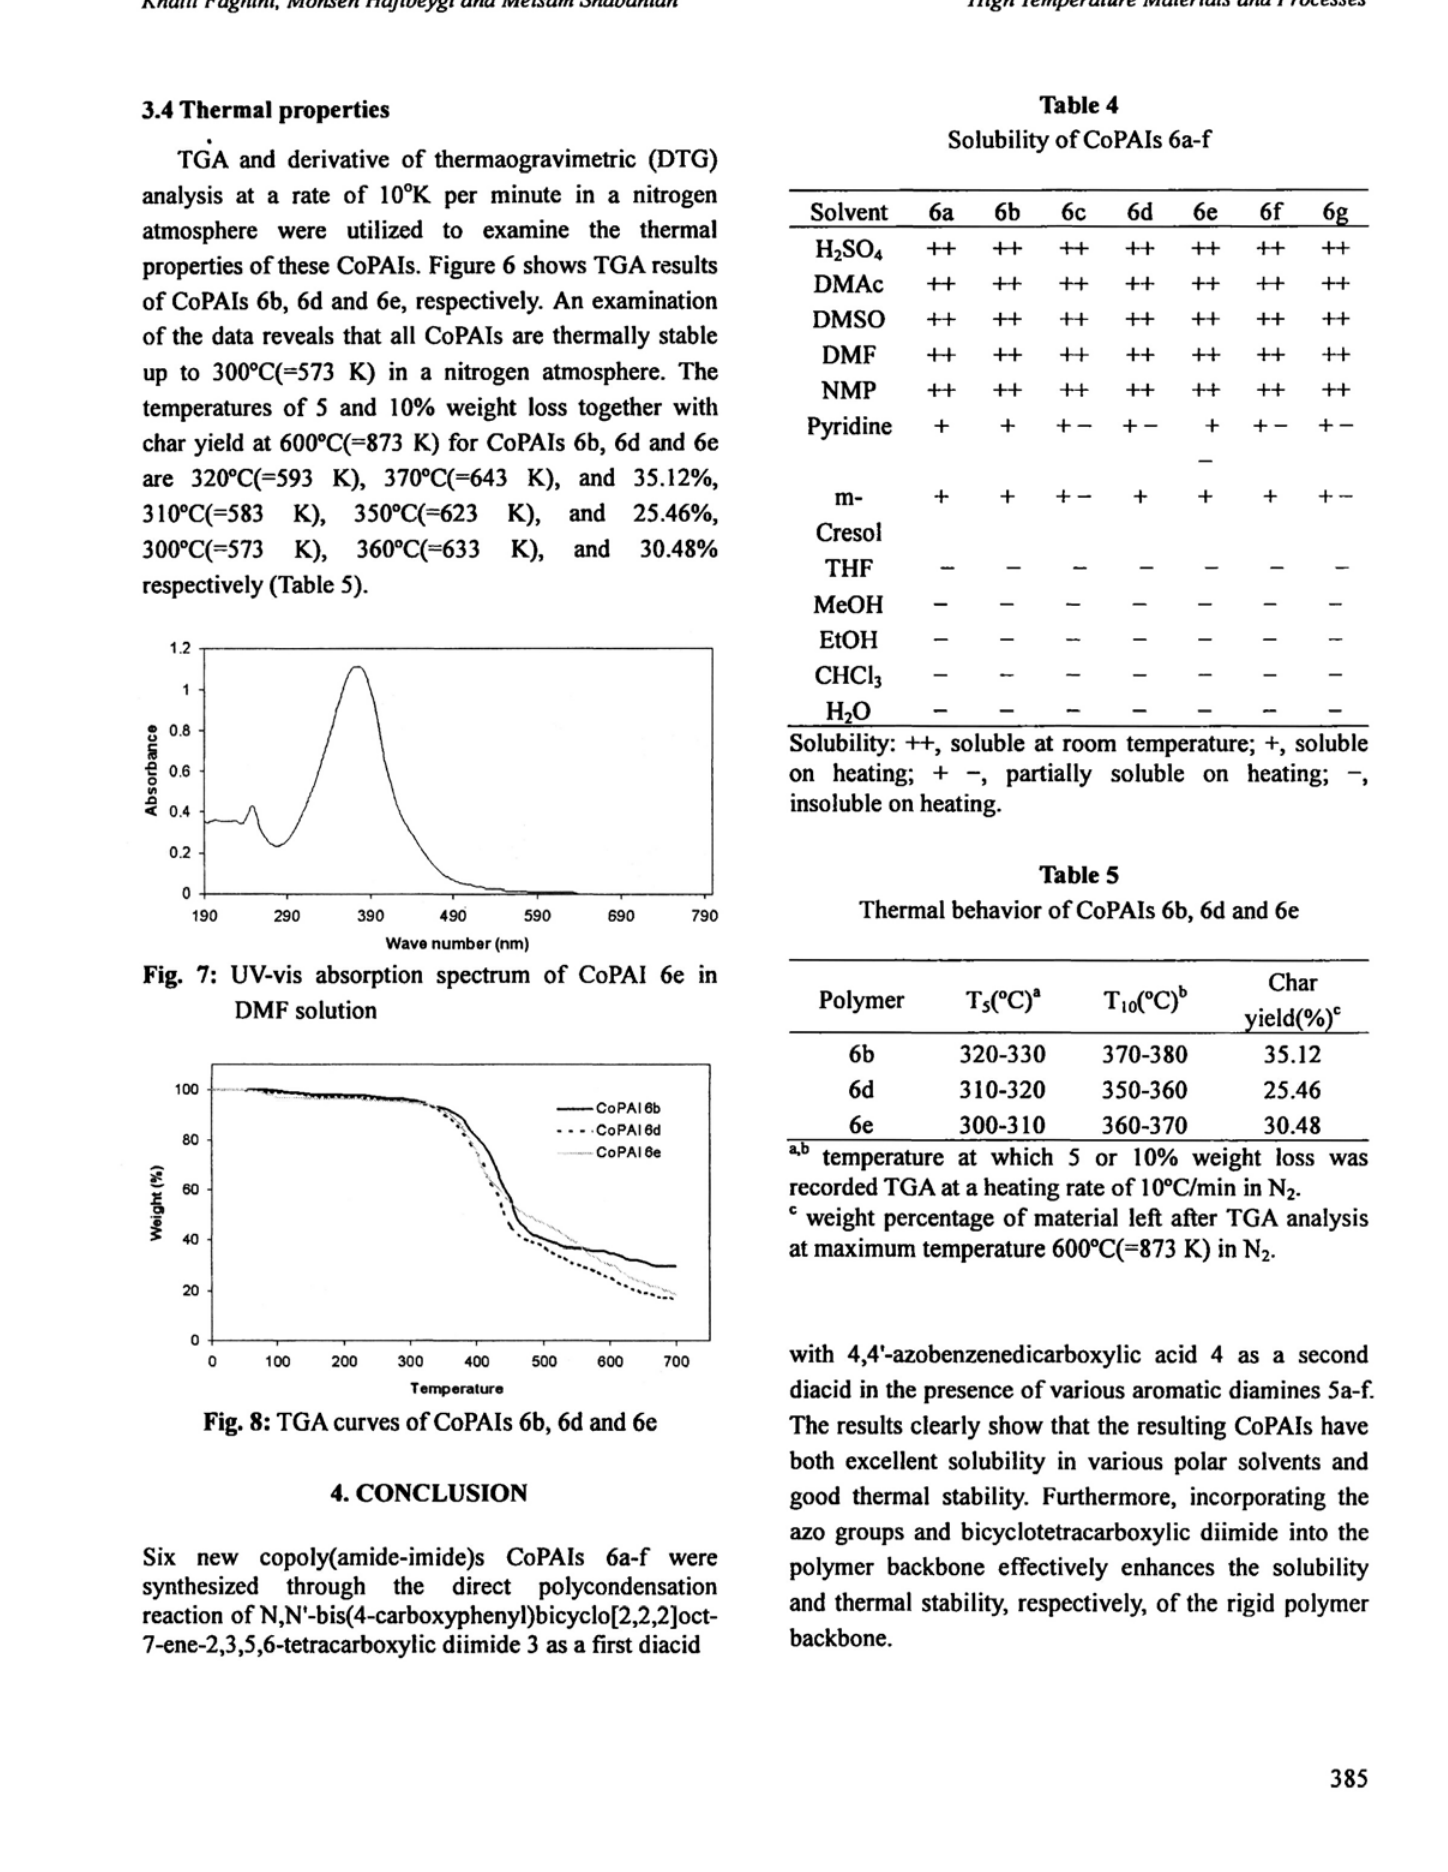
Fig. 7: UV-vis absorption spectrum of CoPAI 6e in